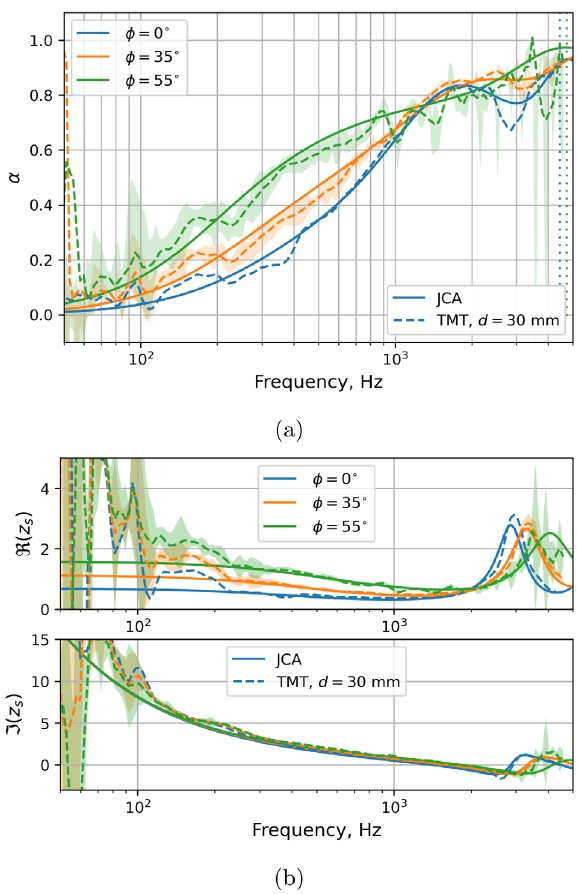
Figure 15. Averaged absorption coef fi cient a for different incidence angles / for the con fi guration shown in Figure 2, with a = 105 cm, b = 33 cm, D m (cid:7) 6.6 cm, k = 10 (cid:3) 9 , z a = 0.5 cm, d = 3 cm. The shaded area shows the variance over 7 values of h 2 [0, 2 p ] and over 9 positions of a regular grid of size 4 cm (cid:1) 4 cm (a) or 20 cm (cid:1) 20 cm